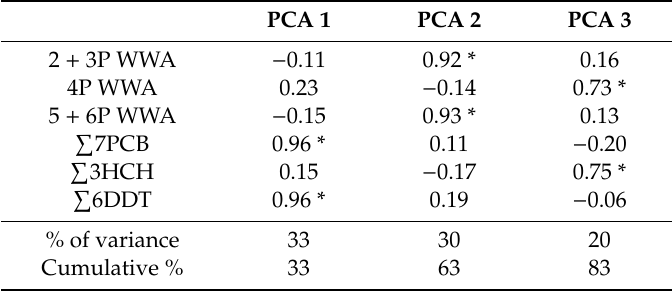
Table 4. Factor analysis, factor loading matrix correlation used to generate the principal component analysis (PCA components (after varimax rotation).